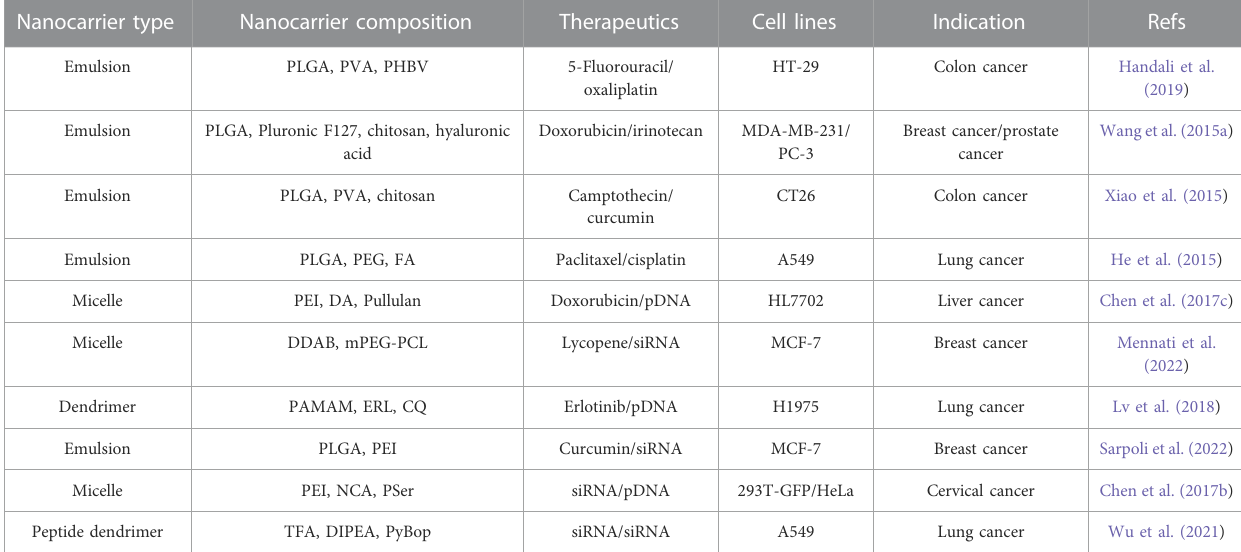
TABLE 2 Polymer-based nanocarriers for simultaneous delivery of therapeutics for cancer